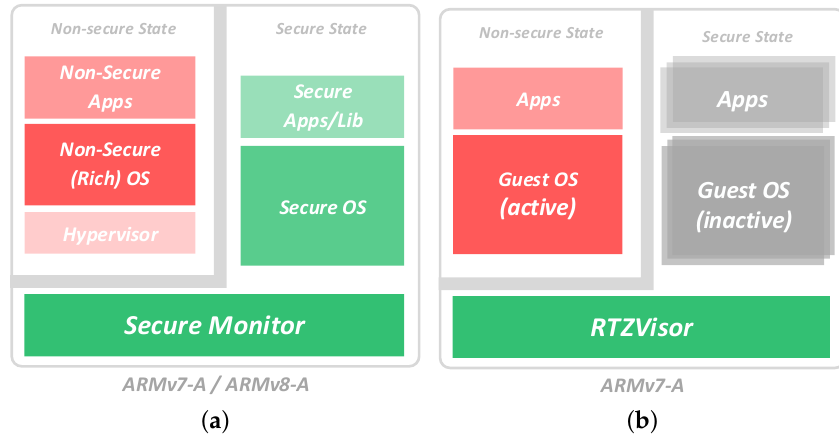
Figure 1. Arm TrustZone: generic architecture and RTZVisor system architecture. ( a ) Arm TrustZone architecture; ( b ) RTZVisor system